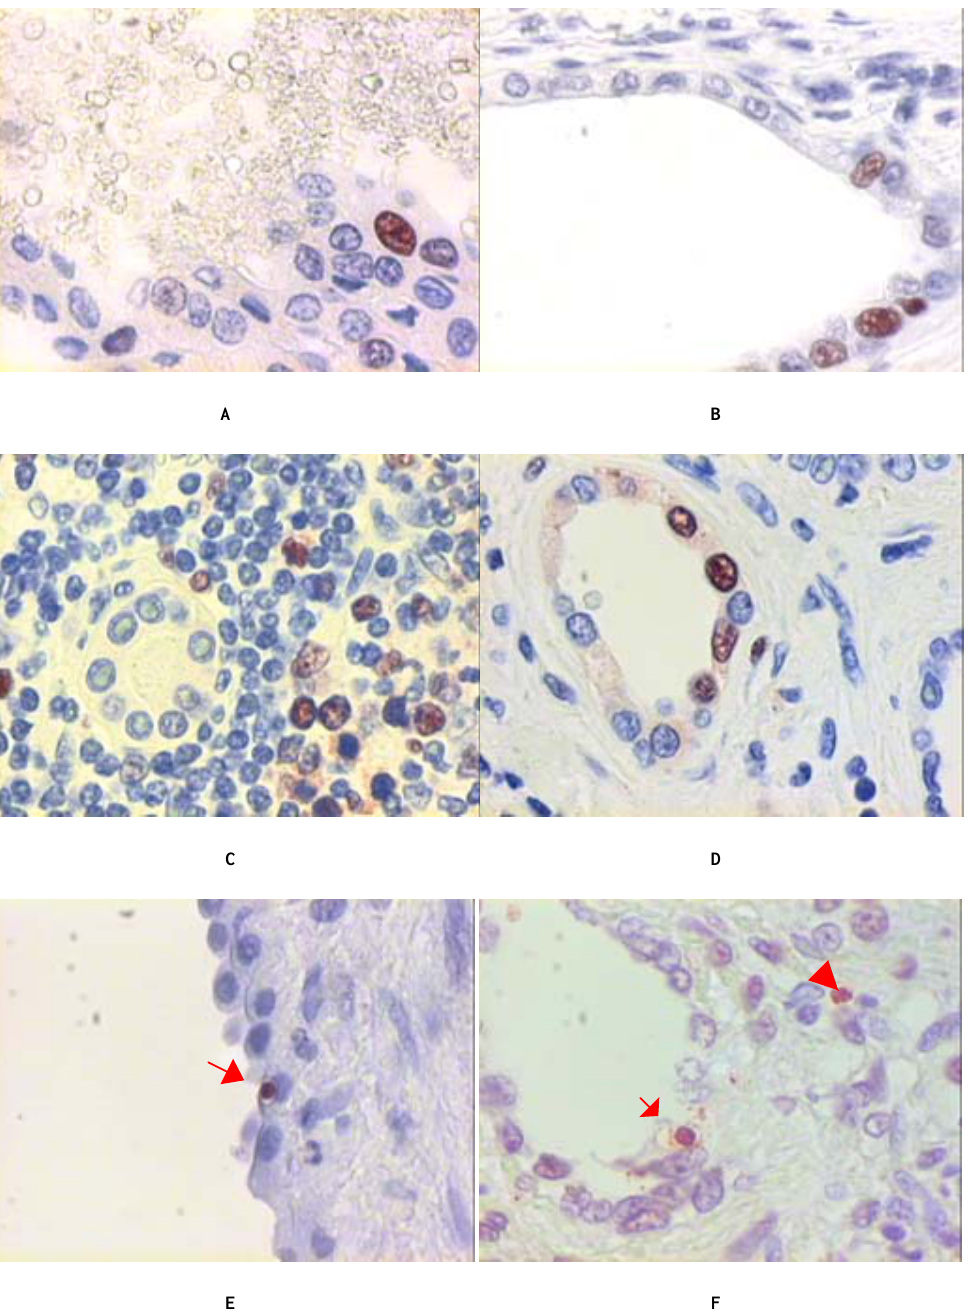
FIGURE 1 Immunostaining of ADPKD sections. (A) PCNA-positive nucleus in the hyperplastic epithelium of a cyst. (B) Multiple PCNA-positive nuclei in the epithelium lining of a cystic tubule. (C) Multiple PCNA-positive nuclei in the epithelium lining a noncystic tubule. (D) A cluster of PCNA-positive nuclei in the interstitium around a noncystic tubule. (E) Apoptotic cell (arrow) within the hyperplastic epithelial cells lining a cyst. (F) Apoptotic cell in the epithelial lining a cystic tubule (arrow) and in the surrounding interstitium (arrowhead). (G) Apoptotic cell in the epithelial lining a noncystic tubule (arrow) and in the surrounding interstitium (arrowhead). (H) A cluster of apoptotic cells located in the interstitium (arrows). (I) Dense interstitial infiltration with CD 68–positive macrophages (using anti CD 68 antibodies). (J) Dense interstitial infiltration with CD 45–positive lymphocytes (using anti CD 45 antibodies). (K) Densely stained hyperplastic epithelium of a cyst using antibodies to EMA. (L) A cyst lined with atrophic epithelium showed negative EMA staining (magnification ×